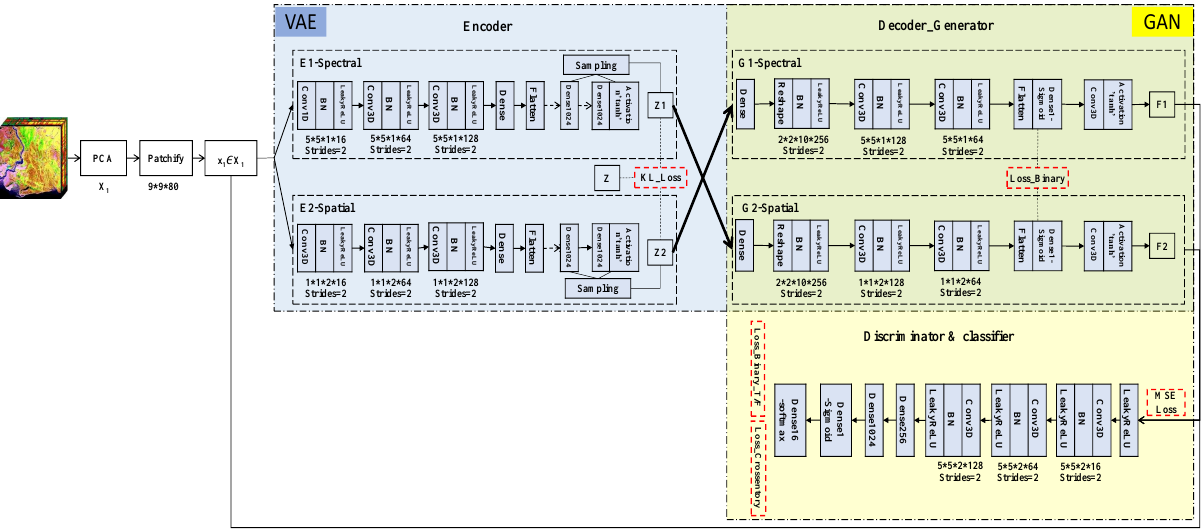
Figure 3. The overall framework of the variational generative adversarial network with crossed spatial and spectral interactions (CSSVGAN) for